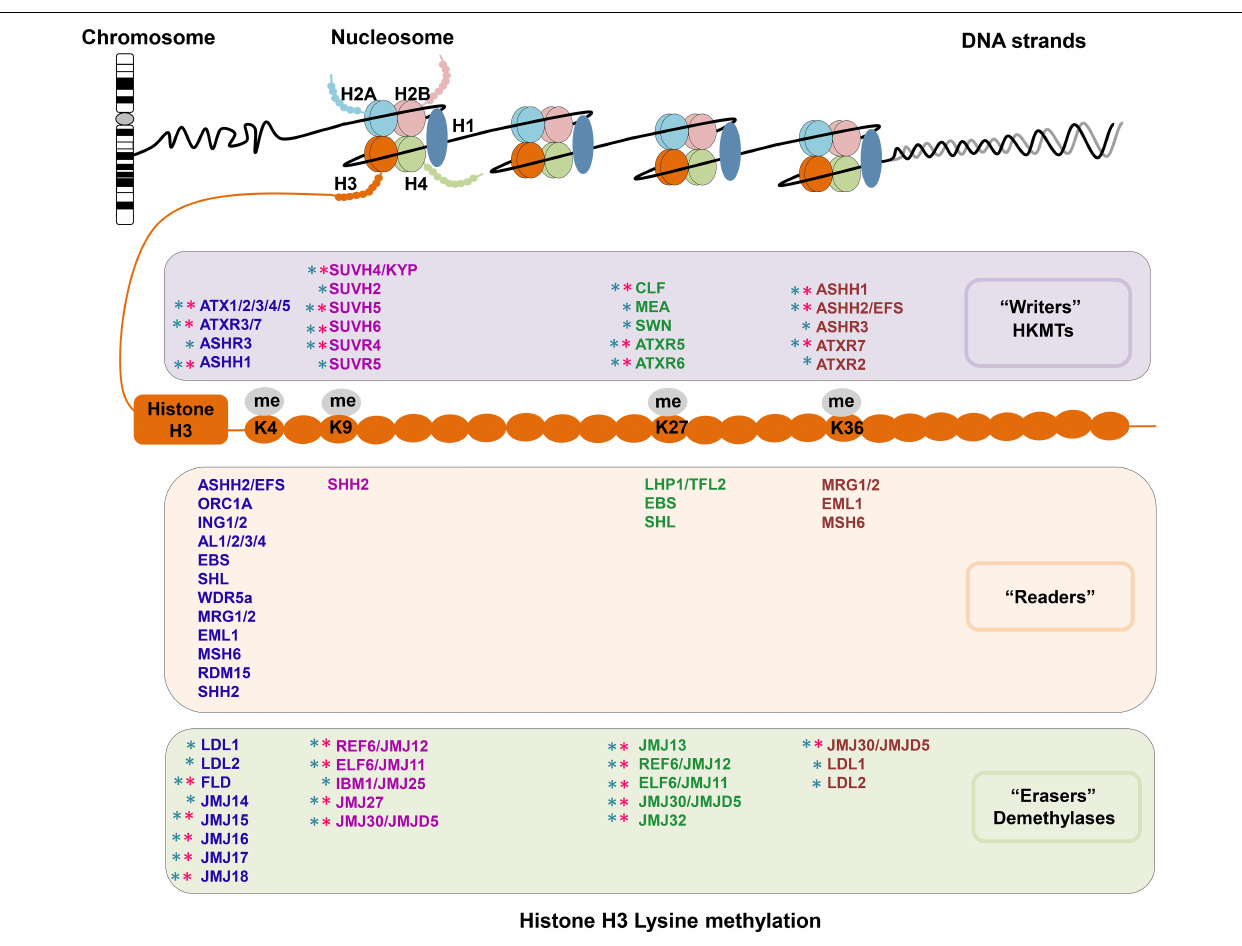
is responsible for H3K4me2 (Saleh et al., 2008). This is